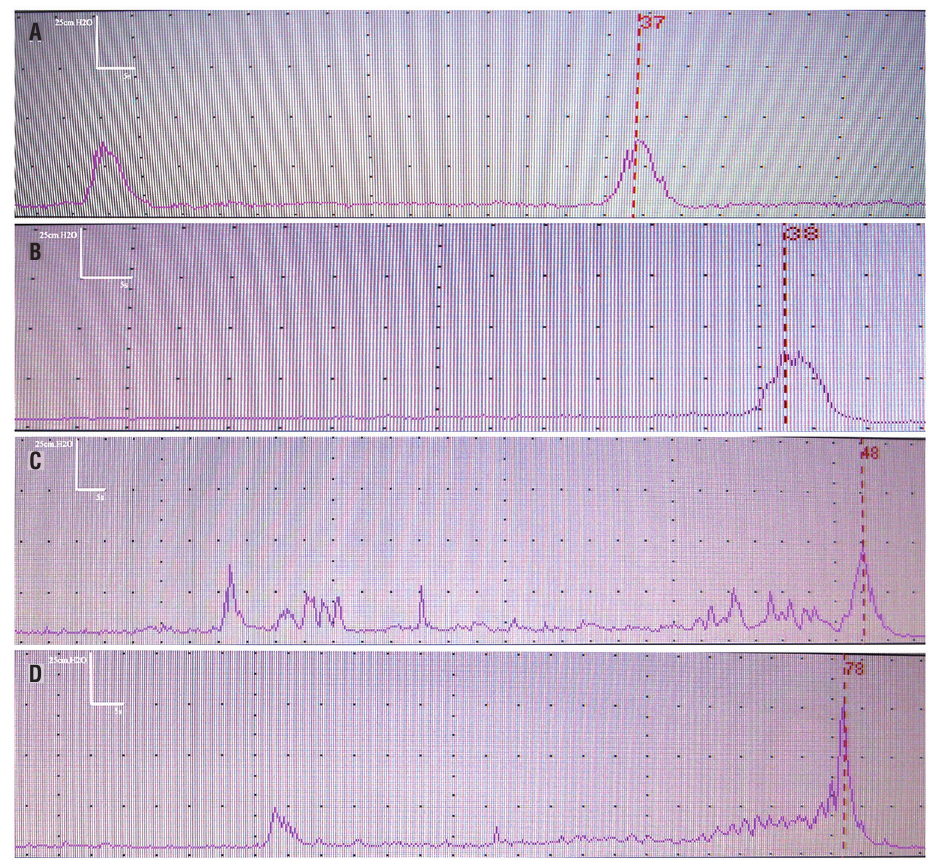
Figure 1 - a) the initial cystometric investigation of the 50 rats before our study (two voiding contractions were observed and the number indicated peak voiding pressure). b) the cystometric investigation of the 10 control rats 6 weeks later (one voiding contraction was observed and the number indicated peak voiding pressure). c) the cystometric investigation of the 6 detrusor overactivity rats 6 weeks later (one voiding contraction was observed and the number indicated peak voiding pressure, the low peak voiding pressure group). d) the cystometric investigation of the 5 detrusor overactivity rats 6 weeks later (one voiding contraction was observed and the number indicated peak voiding pressure, the high peak voiding pressure